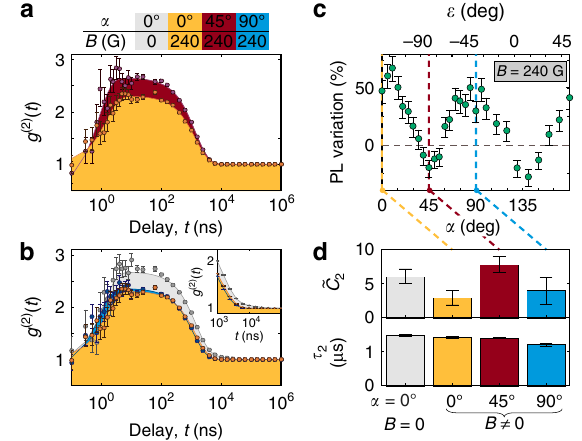
Fig. 3 Photon emission dynamics. a , b Measurements of the photon autocorrelation function for different orientations of the defect with respect to an in-plane magnetic fi eld ( β = 0°) as indicated by the color-coded caption. No background correction is applied to the data, and error bars represent the Poissonian uncertainty based on the photon counts in each bin. b, inset Detailed view of the long timescale component ( τ 3 ) visible only when B = 0 G. c PL variation as a function of sample orientation under an in-plane magnetic fi eld at 240 G. Error bars are determined in the same manner as for Fig. 2a. d Best- fi t values of the background-corrected bunching amplitude, ~ C , and corresponding timescale, τ 2 , for the data in a 2 and b . Error bars represent 68% con fi dence intervals from fi ts to the data in a and b , propagated to corresponding background-corrected values including experimental uncertainty in the signal and